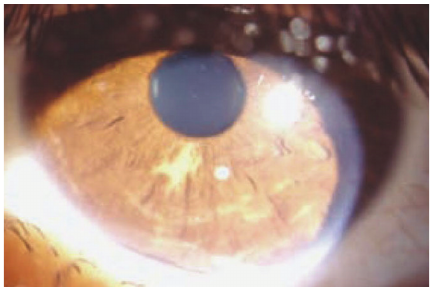
Figure 11: Slit lamp photograph of the anterior segment in a patientwithtuberoussclerosiscomplex.Ahypopigmented“ashleaf” shaped area is visible on the iris (from [6]).